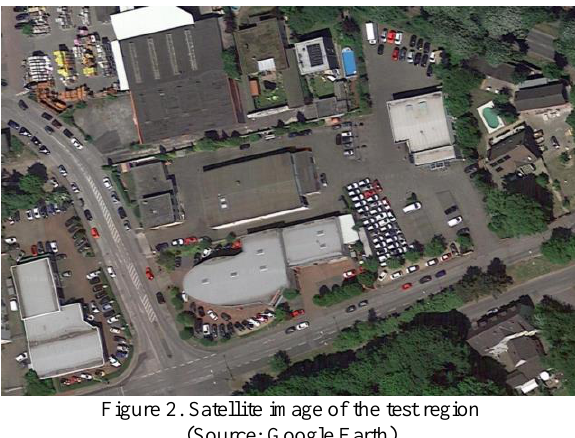
Figure 2. Satellite image of the test region (Source: Google Earth)